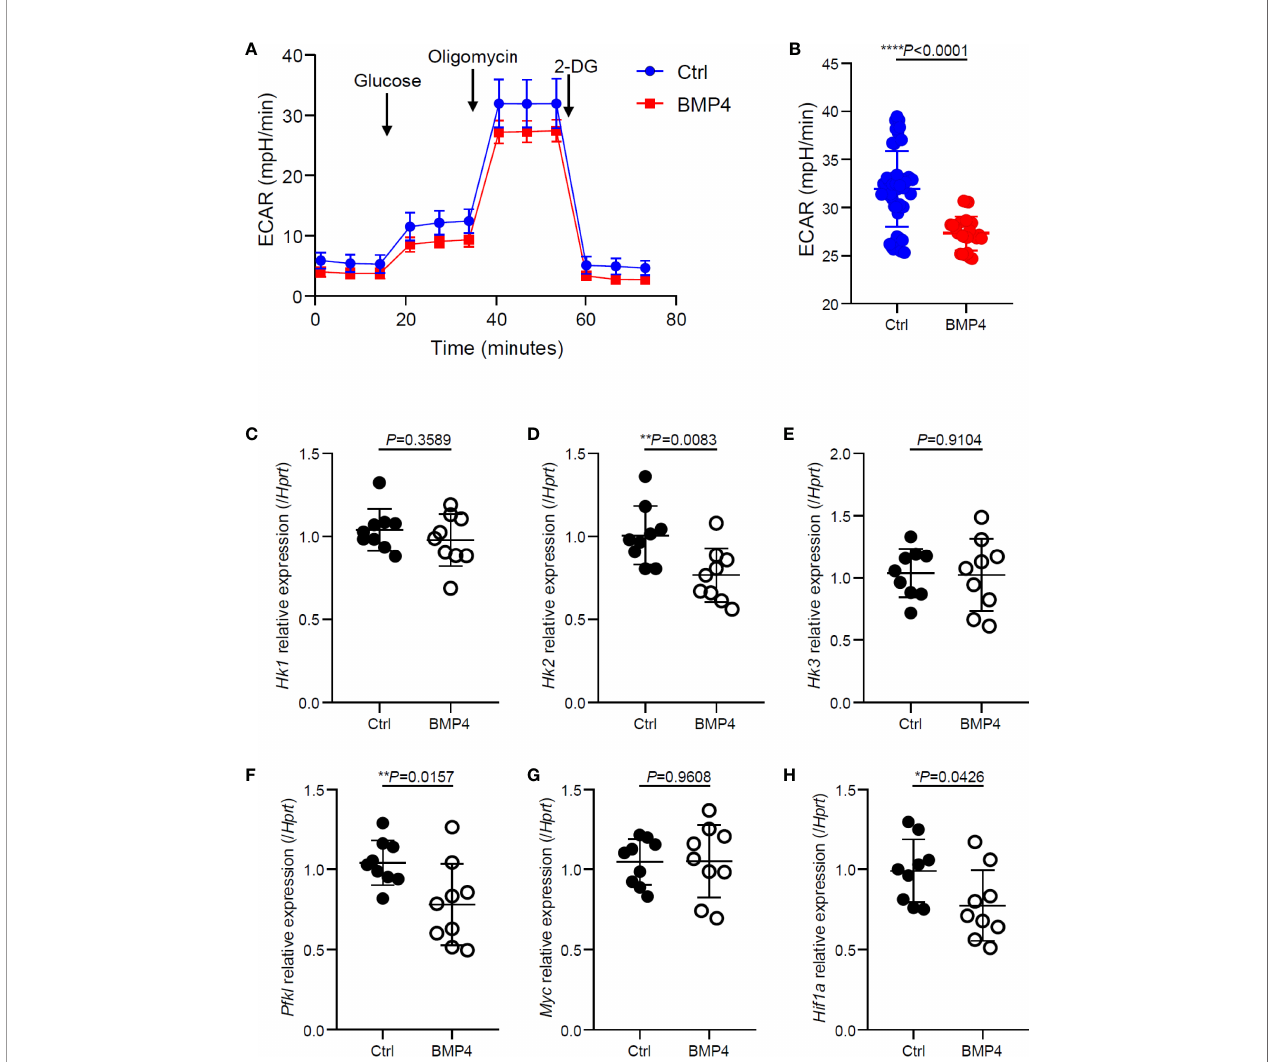
FIGURE 3 | BMP4 moderates glycolysis of T cells after activation. (A, B) Extracellular acidi fi cation rate of T cells 24 hours after TCR activation with or without BMP4 treatment. (C – H) The gene expression of Hk1, Hk2, Hk3, Pfkl, Myc and Hif1a checked by Quantitative real-time